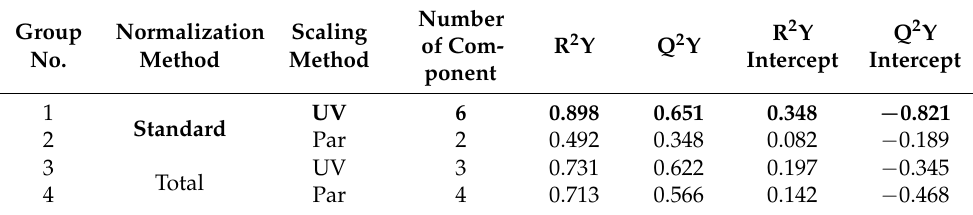
Number of components obtained from autofit function in SIMCA software; PLS-DA, partial least squares discriminant analysis; Standard, standardized area normalization; Total, total area normalization; UV, unit variance; Par, Pareto; The bold characters indicate the selected optimal model